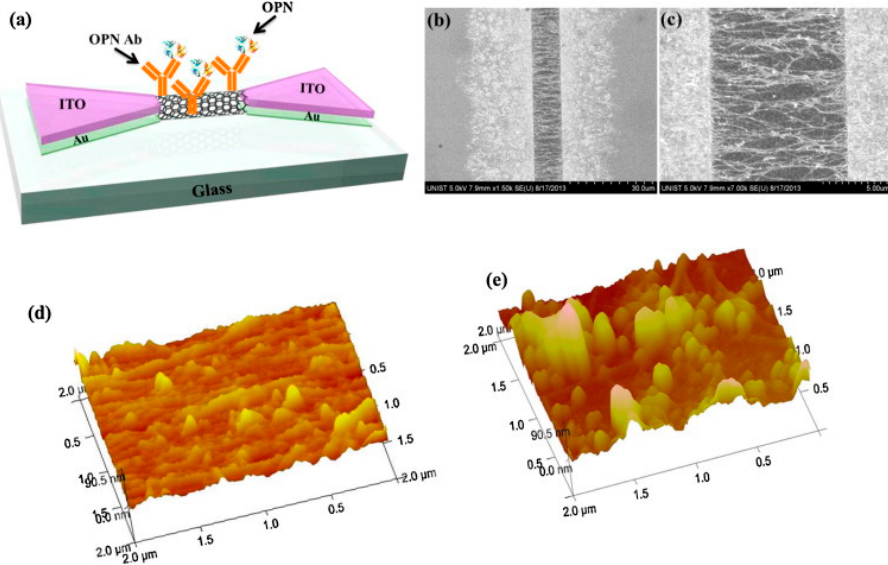
Figure 7. Electrical immunosensor for detection of osteopontin (OPN). ( a ) Schematic of the transpar- ent SWCNT based immunosensors for OPN detection, where OPN antibodies were immobilized on the SWCNT surface between the source and the drain electrodes on a glass substrate, ( b ) FE-SEM micrographs of SWCNTs between Au/ITO electrodes, ( c ) FE-SEM micrographs of SWCNTs at higher magnification, ( d ) AFM images of the SWCNTs deposited between two Au/ITO electrodes, and ( e ) AFM images of OPN antibody covalently attached to -COOH functionalized SWCNT surfaces. Reprinted from ref. [161]. Copyright (2015) with permission from